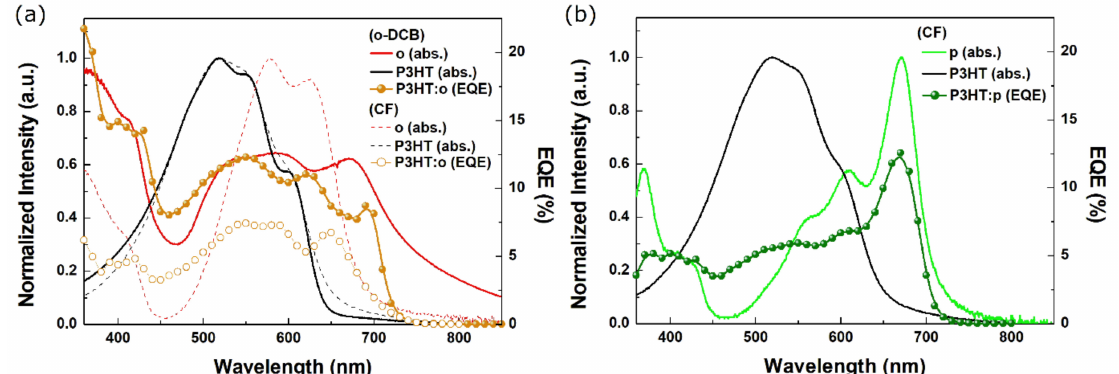
Figure 3. External quantum efficiency (EQE) responses of the binary solar cells fabricated with ( a ) P3HT: o -DPP-PhCN (o) and ( b ) P3HT: p -DPP-PhCN (p) films; the UV-vis spectra of the neat films of each donor and acceptor used in the devices are included for comparison.